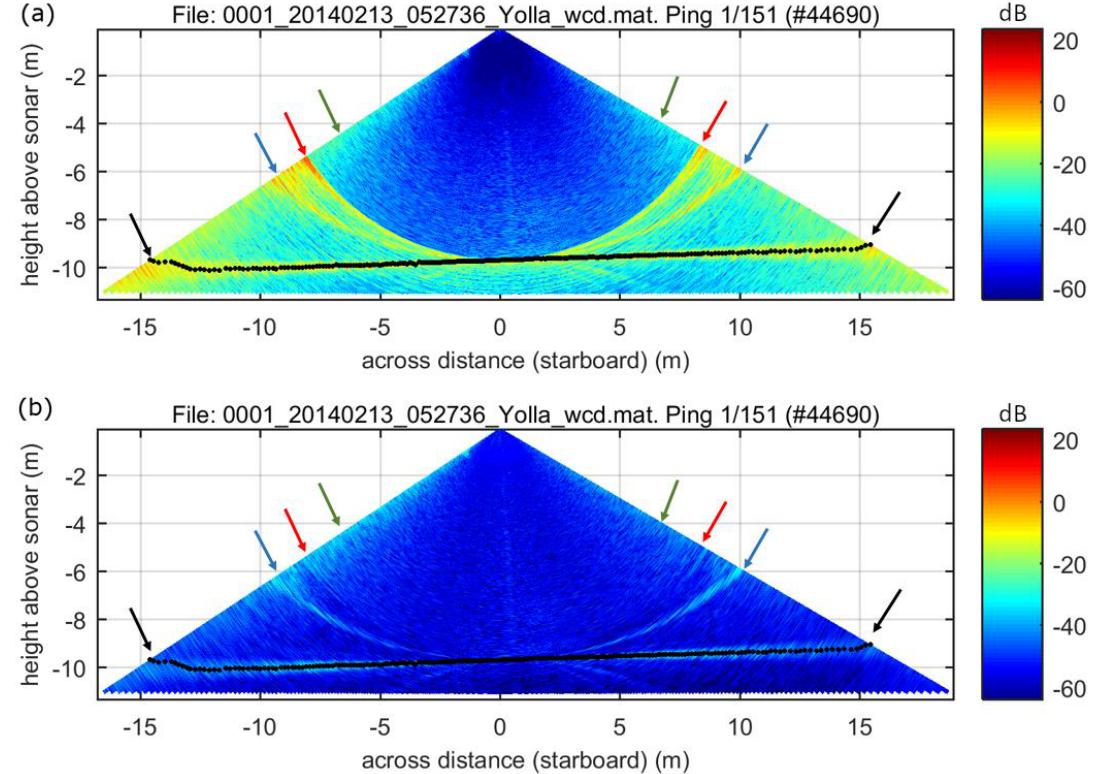
Figure 3. Illustration of EM 2040 C MBES water-column data acquired in an area with no water-column targets: ( a ) before and ( b ) after application of the slant-range signal normalization (SRSN) filter. Data shown are for the first ping of the first file (300 kHz, 25 µ s “very short” CW), displayed in the swath plane with the sonar head as axes origin. The coloured arrows point at: (black) the seafloor echo, (red) the specular artefact, (blue) the unidentified artefact, and (green) outer-beams high noise level. The detected bottom is also shown overlaying the seafloor echo as black